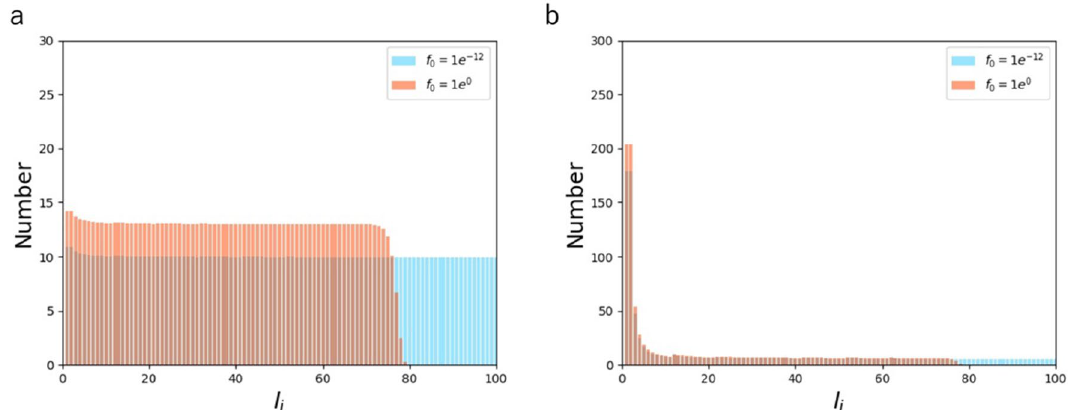
Figure 3. Length distribution of AFs comprising of N = 1000 monomers with f 0 = 10 –12 (blue) and f 0 = 1 ′ k b = 0.1 ( a ) and k ′ k b = 4 ( b (orange) at k b / b /